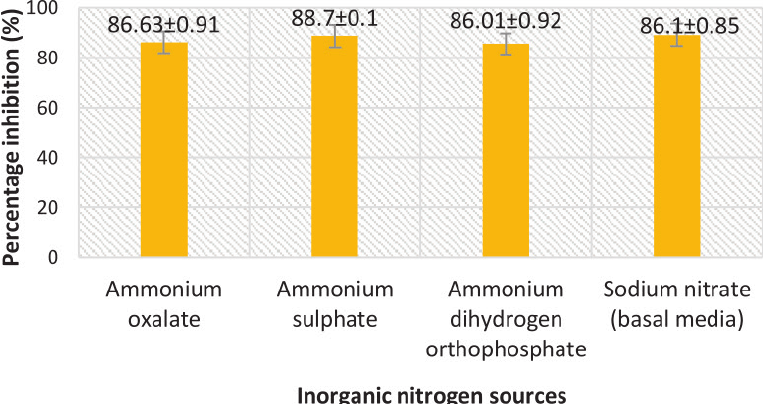
Fig. 6. Percentage inhibition of A. flavus growth in different inorganic nitrogen sources where the inhibitions are significantly less compared to those obtained for beef extract. Inhibition percentage = (Control- Test/ Control) x100. Values are represented as Mean ± SD (n=3)